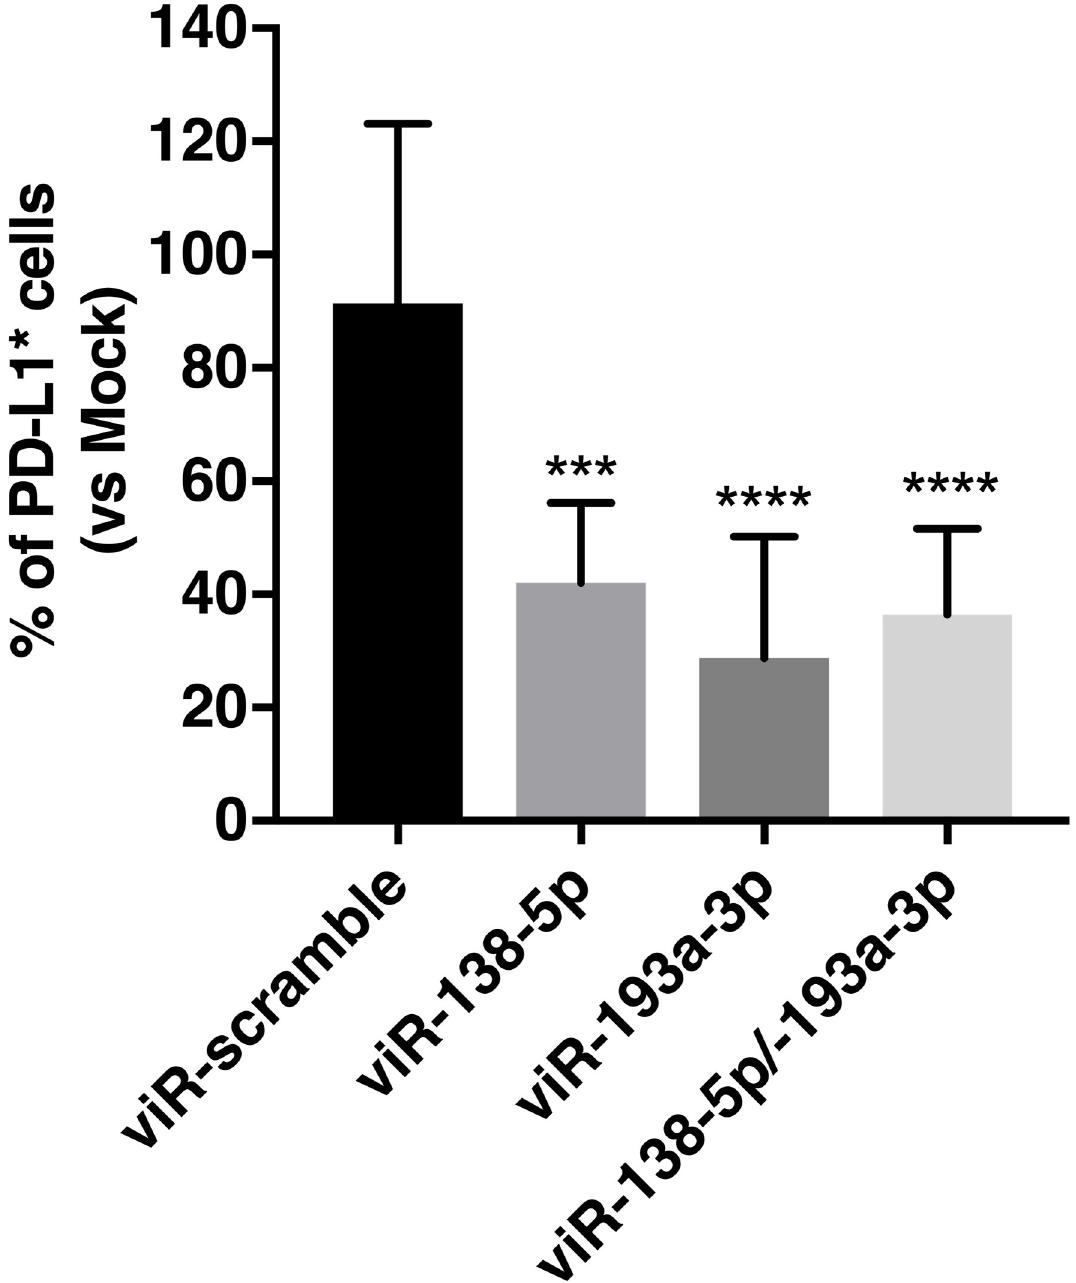
Fig 8. MiRNA mimics delivered intratumourally with viRNA platform enables efficient down-regulation of cancer cell- expressed PD-L1. B16.OVA tumour-bearing mice were treated intratumourally with either viR-138-5p, viR-193a-3p, viR-138-5p/ 193a-3p or viR-scramble as a control on days 11 and 14 post-tumour implantation and mice were sacrificed and tumours collected on day 16. PD-L1 protein levels were analysed by flow cytometry using antibody against human PD-L1. Data shown as a mean ± SEM. One-way ANOVA followed by Dunnett’s multiple comparisons test. ��� p-value < 0.001 and ���� p-value < 0.0001 compared to viR-